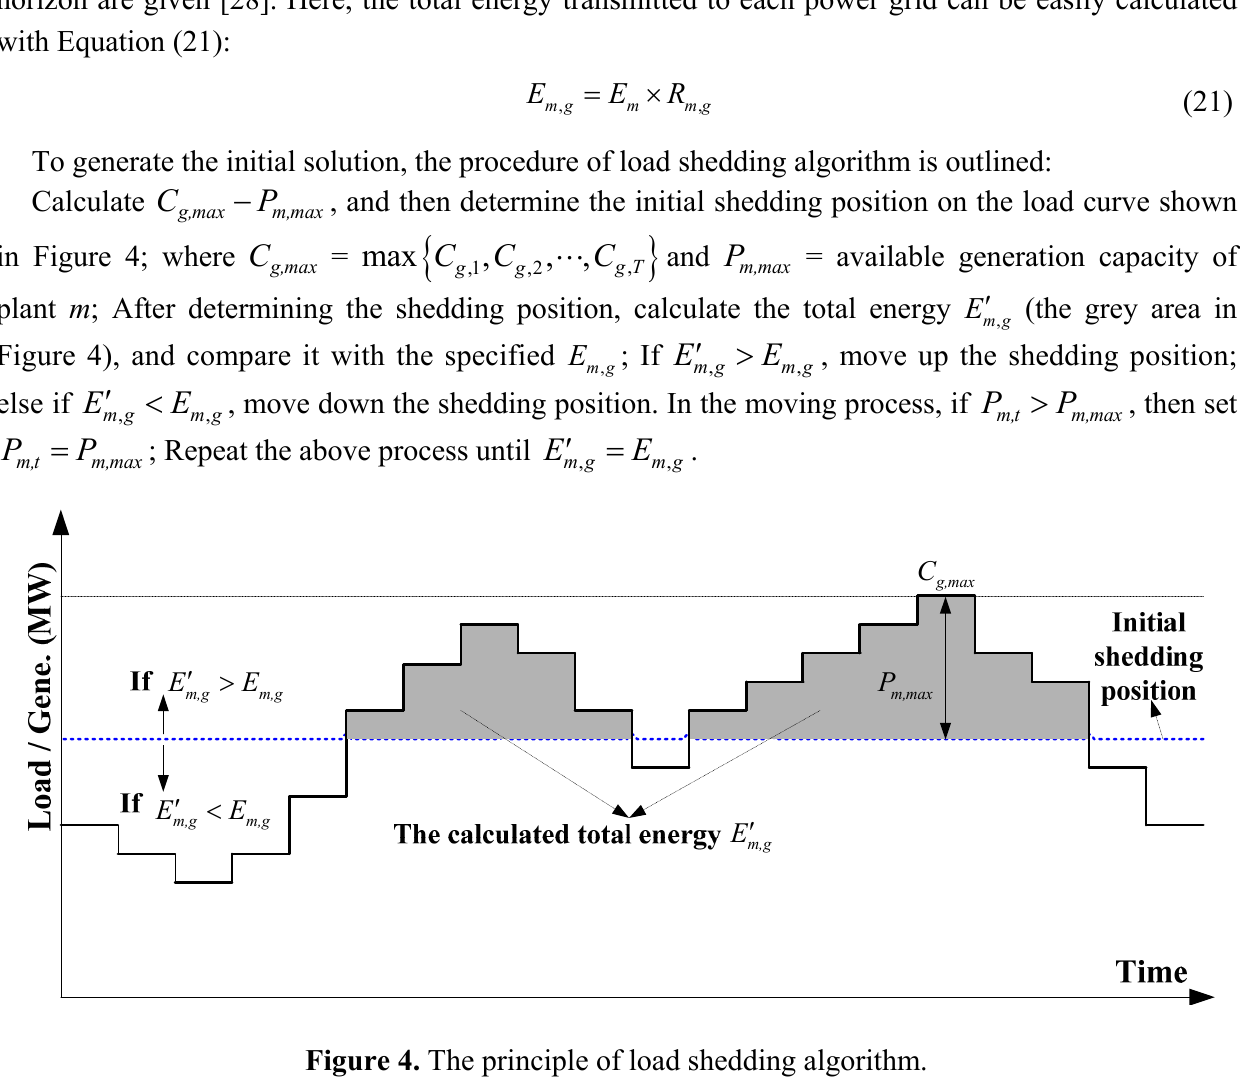
Figure 4. The principle of load shedding